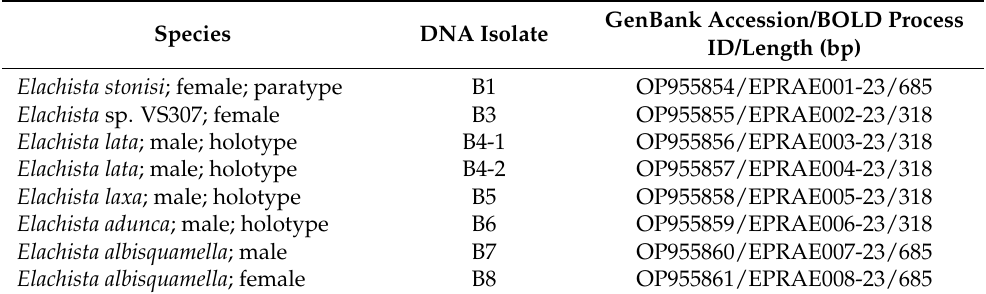
Table 2. Specimens used for molecular analysis of Neotropical species of Elachista praelineata species